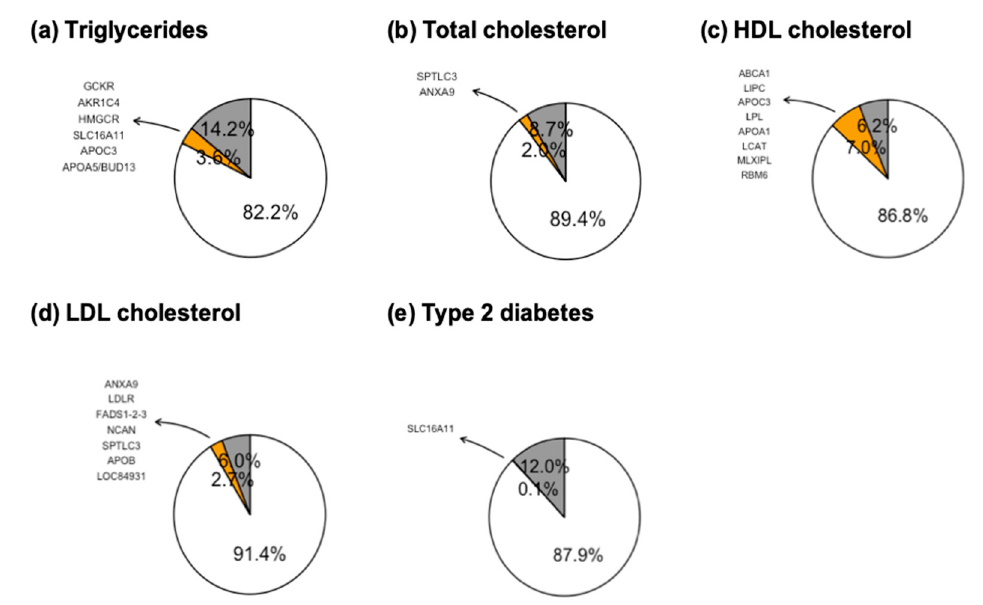
Figure 2. Contribution of common single nucleotide polymorphism (SNPs) to the genetic variance of lipid levels in Mexico. It is shown the variance explained by previously associated genes (yellow), as well as by environmental covariates (grey): age, sex, body mass index (BMI), ancestry and type 2 diabetes (T2D), specifically for lipid traits. In addition, the most associated genes with lipid levels ( a–d ) and T2D ( e ) in Mexican population are shown.